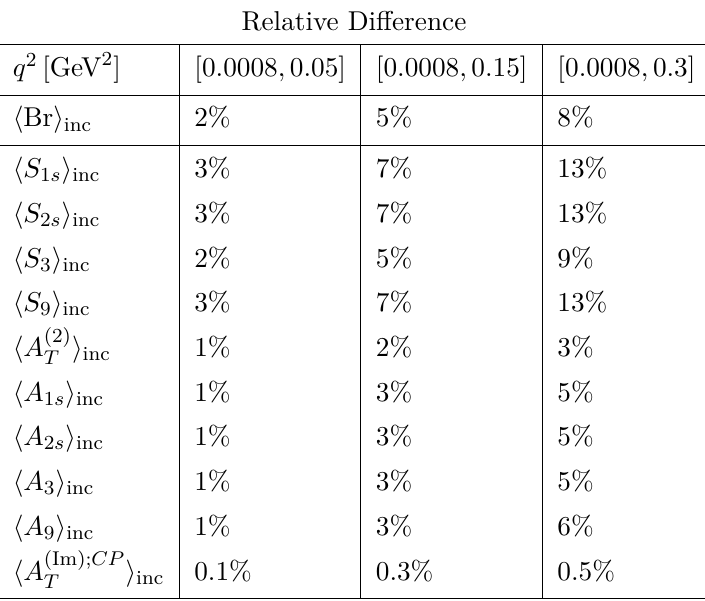
Table 5 . Relative difference between the mean value for the observables and the photon- pole approximation for three different bins of q 2 ∈ [0 . 0008 , 0 . 05] GeV 2 , [0 . 0008 , 0 . 15] GeV 2 and [0 . 0008 , 0 . 3] GeV 2 . For Br, S A 2 s , A 3 , A 9 and A ( Im ); CP